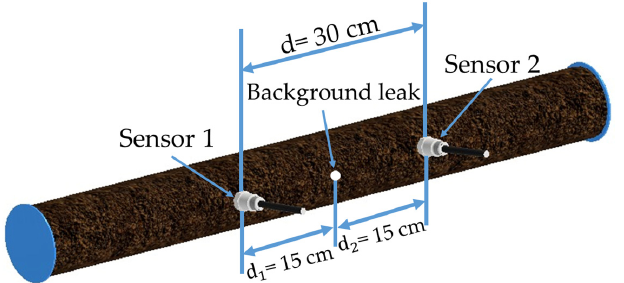
Figure 1 . Scheme for background leakage detection. Figure 1. Scheme for background leakage